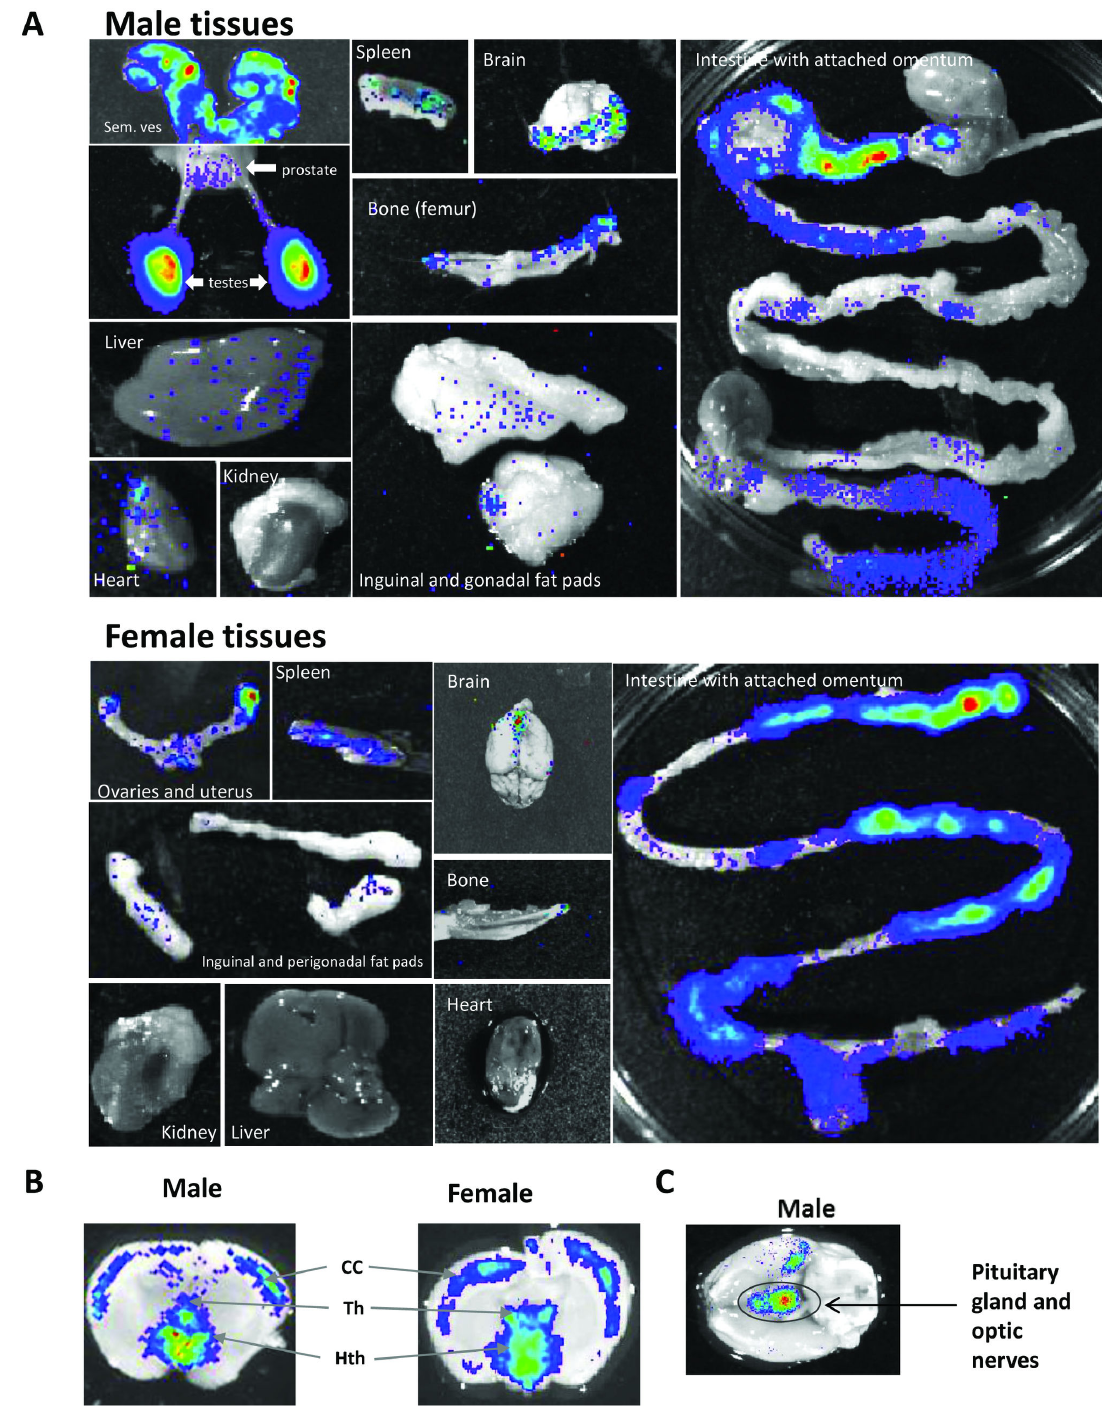
Figure 3. Bioluminescence analysis of ex vivo tissues. Ex vivo bioluminescence imaging of tissues taken from ARE-Luc mice injected with 150mg/kg luciferin substrate and killed and dissected after 10 minutes. ( A ), Images of male tissues (upper panel) and female mice (lower panel). ( B ), Images of coronal sections through the cerebral cortex of a male and female mouse brain. CC - Cerebral Cortex, Th - Thalamus, Hth - Hypothalamus. ( c ), Image of the underside of the male brain, showing pituitary and optic nerve bundles. Figure represents a greyscale photograph overlaid with a pseudocolour representation of bioluminescence. Images are representative of the pattern seen in several mice. doi: 10.1371/journal.pone.0071694.g003 PLOS ONE |